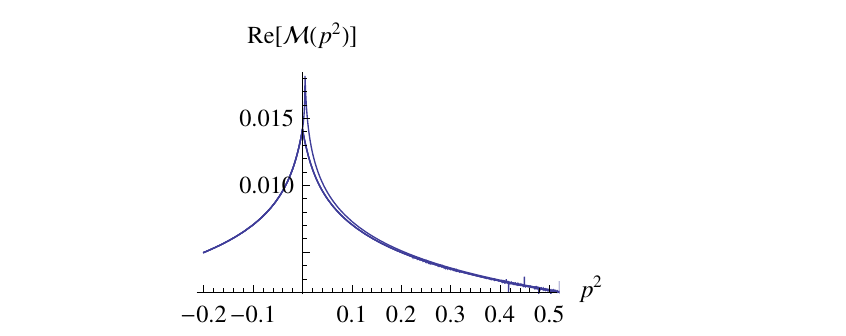
p = 1 ; 2 ; 3, with M = 1 (left picture) and M = 1 = 20 j j